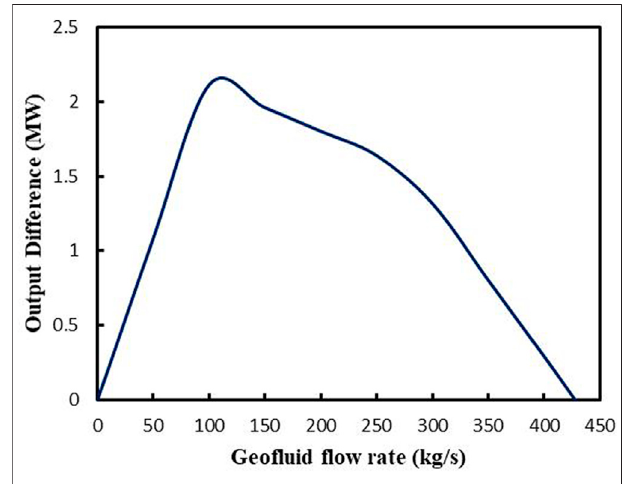
FIGURE 10 | Power output difference between two kinds of GAPG plants with the same amount of geothermal integration.